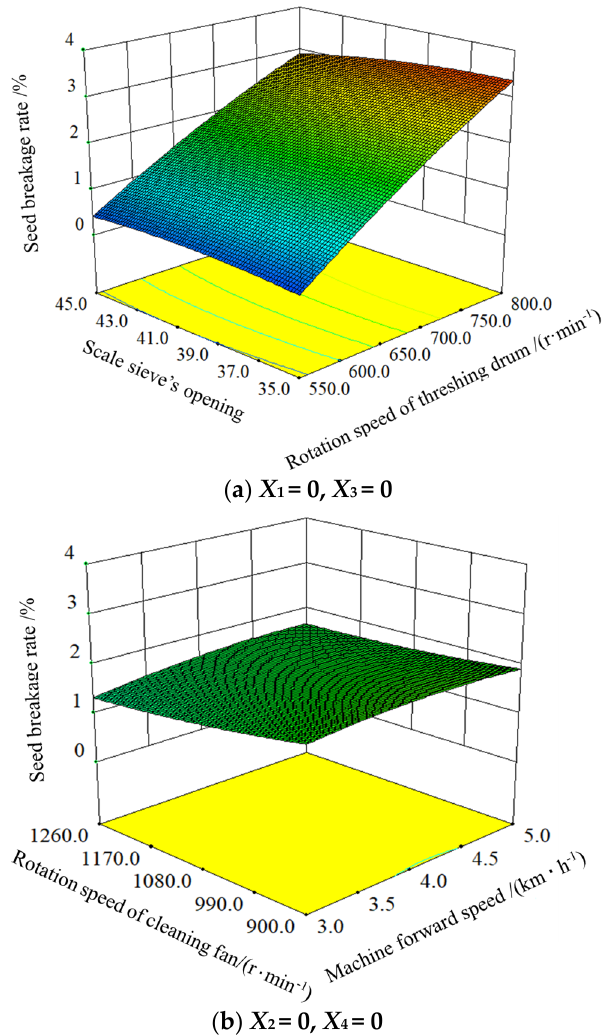
Figure 11. Response surfaces of seed breakage rate.